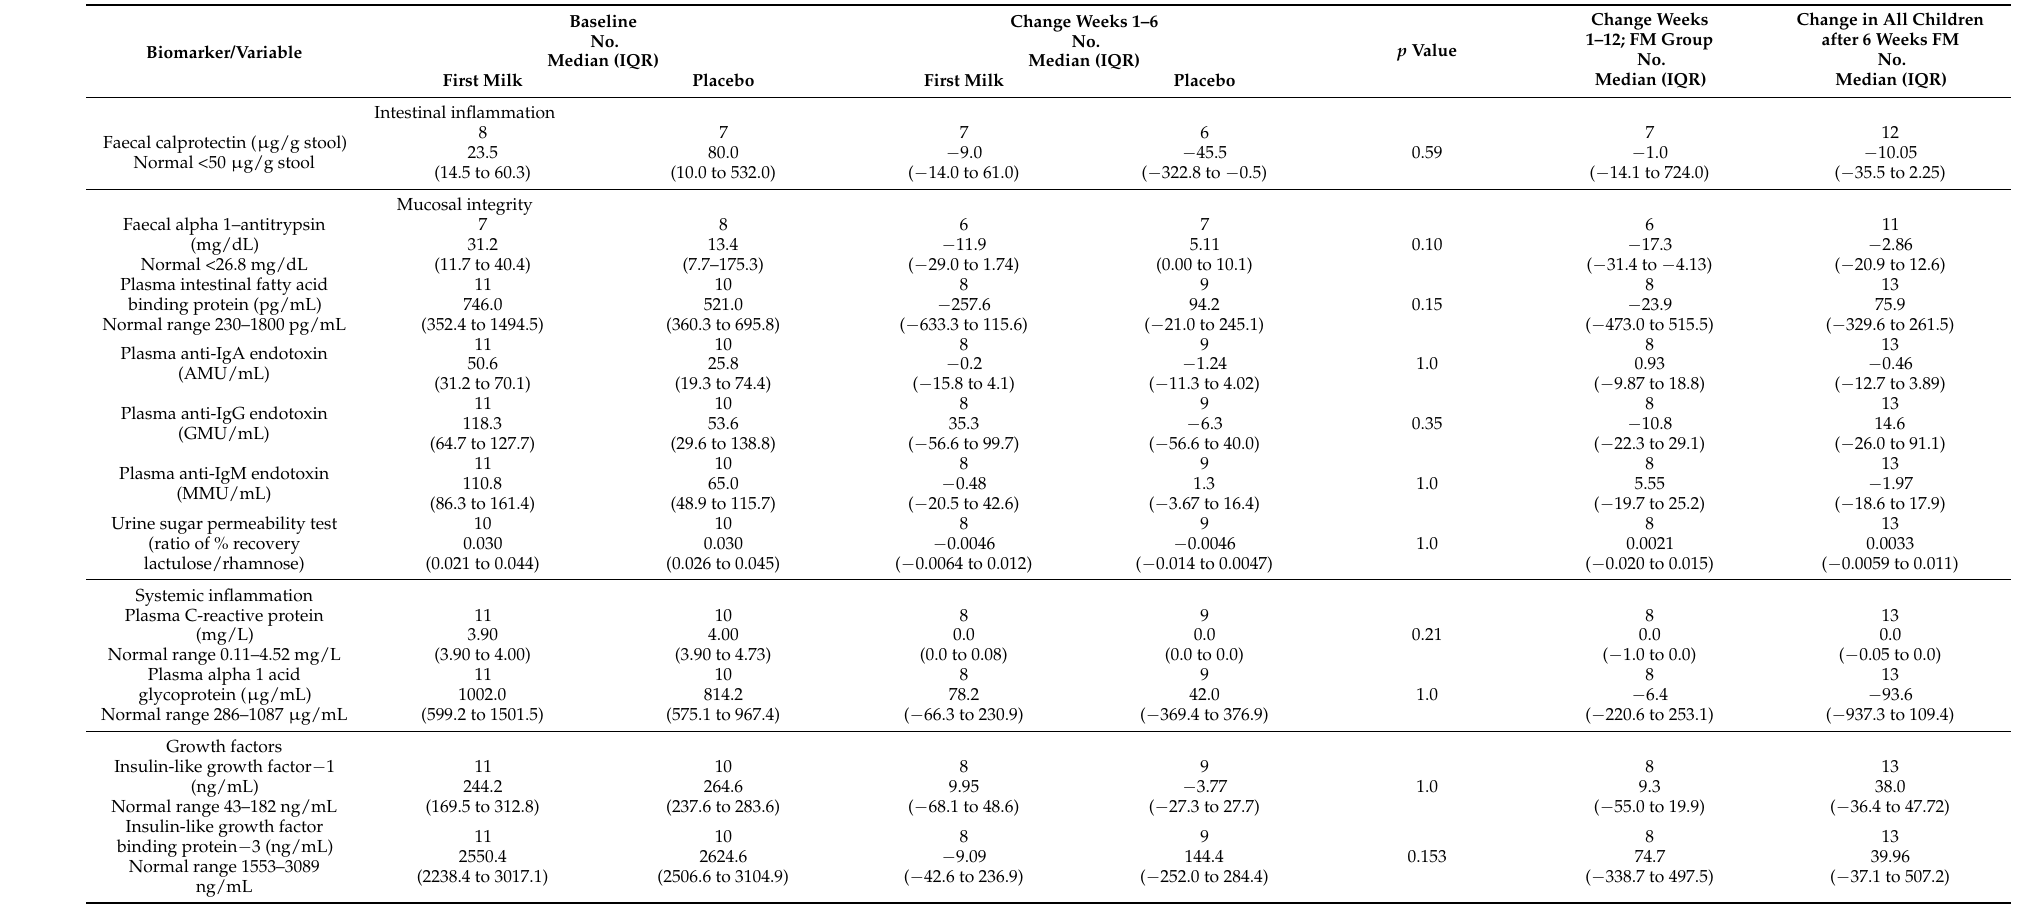
Table 3. Laboratory biomarkers according to intervention